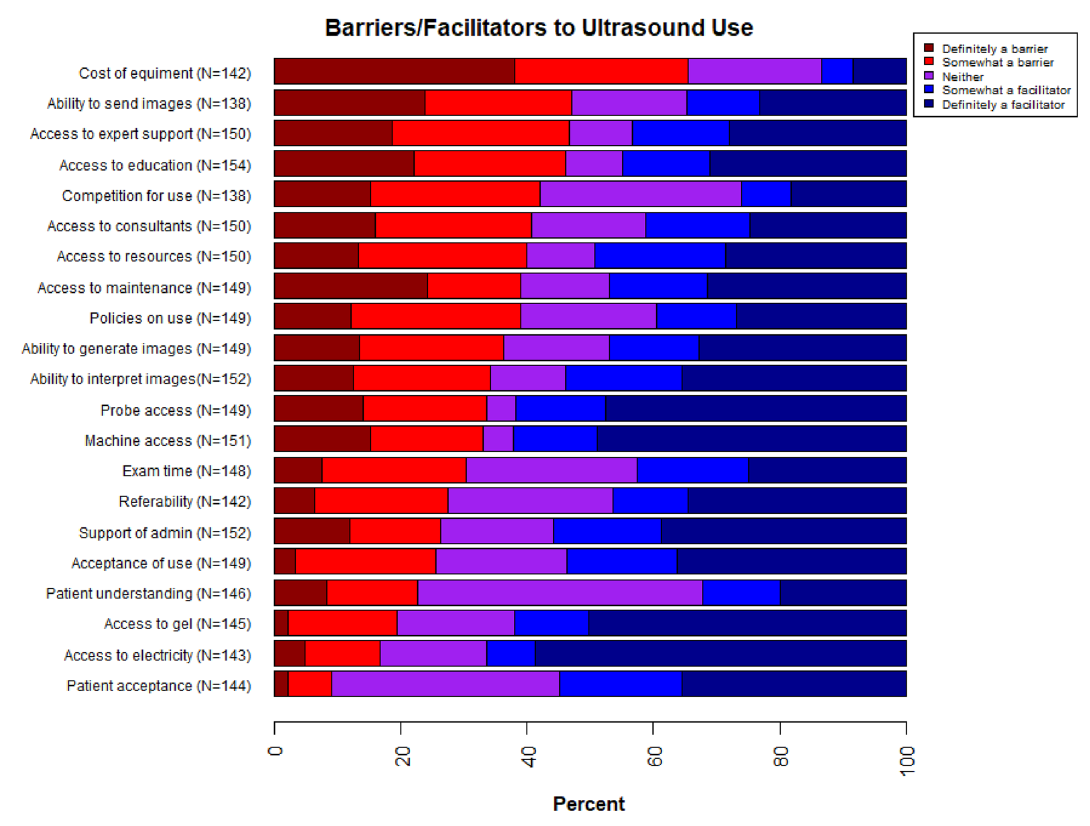
Figure 2. Barriers and facilitators to ultrasound use in low- and middle-income